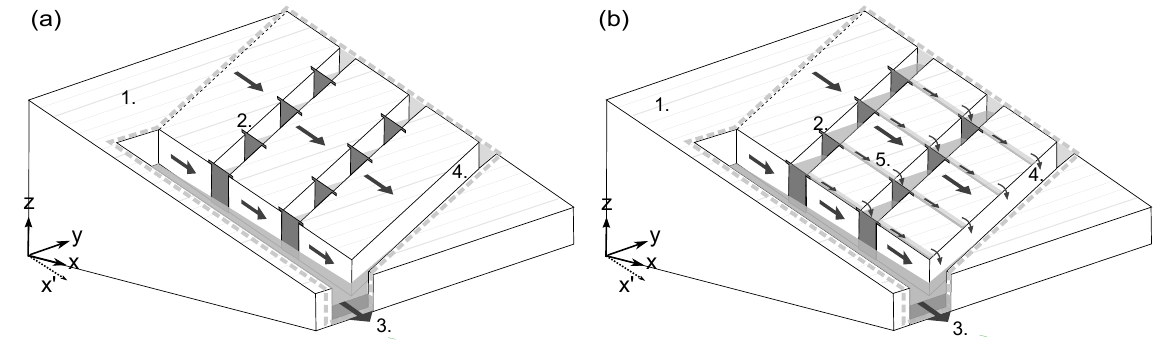
Fig. 1. Conceptualisation of flow paths in a blocked drain peatland; (a) as the blocked drains are filling and (b) as the blocked drains are overflowing. Annotated items: (1) hillslope contours, (2) drain dams, (3) field outlet, (4) unblocked drain, (5) overflow from the blocked